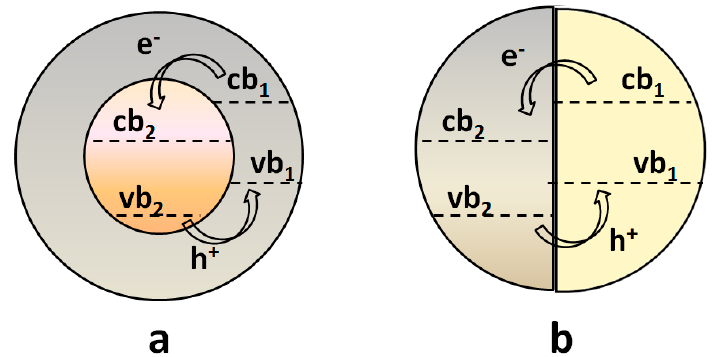
Figure 6. Core shell ( a ) and Janus type ( b ) structures.